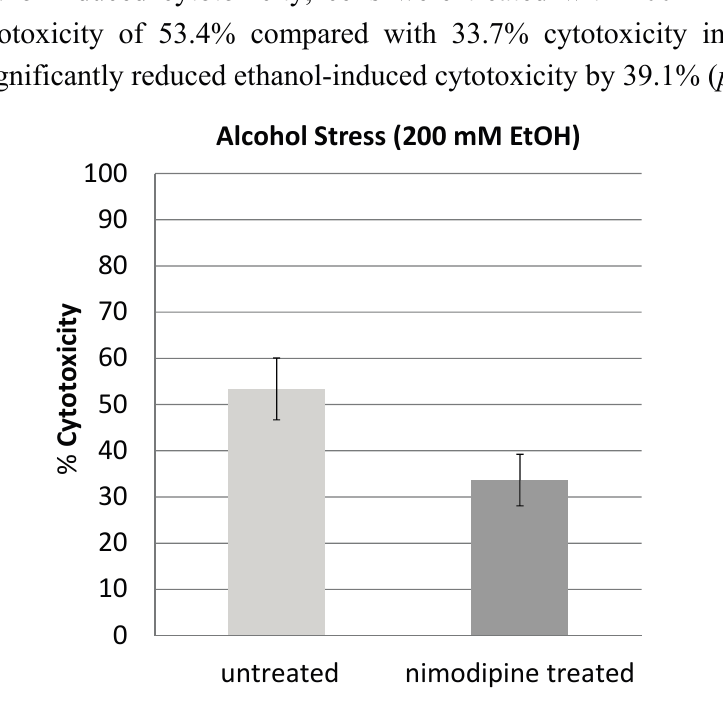
Figure 2. PC12 cells were treated with 200 mM EtOH and 20 μ M nimodipine or DMSO and incubated for 48 h. The EtOH induced cytotoxicity of 53.4% in the untreated